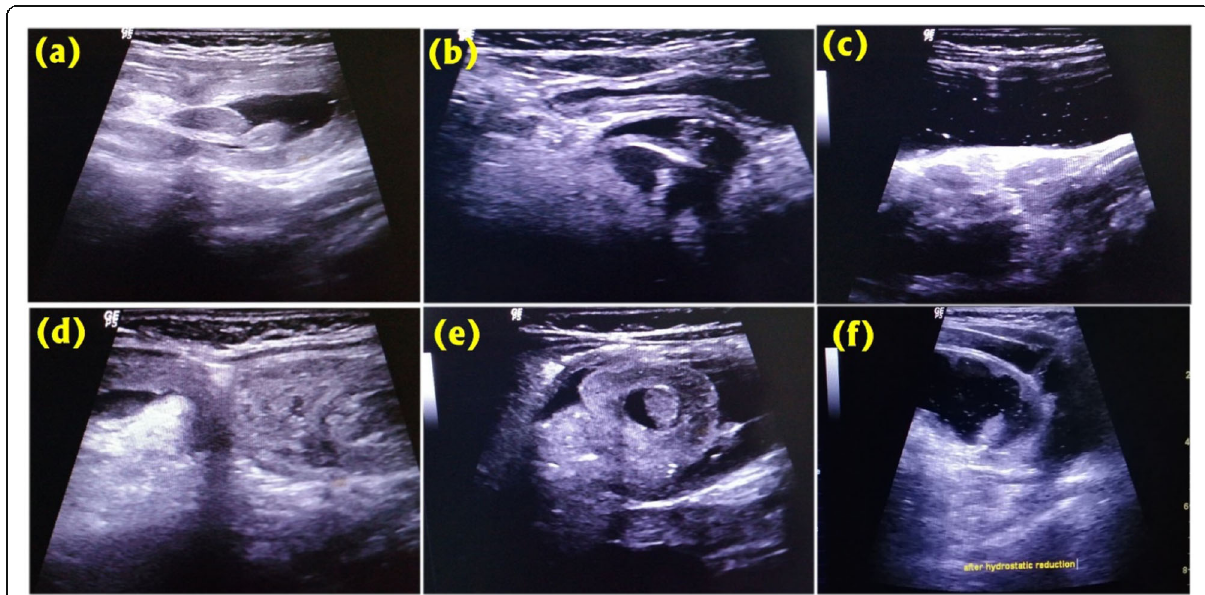
Fig. 2 U/S pictures showing different levels of reduction using saline enema for reduction of intussusception. a , b Enema solution start to push